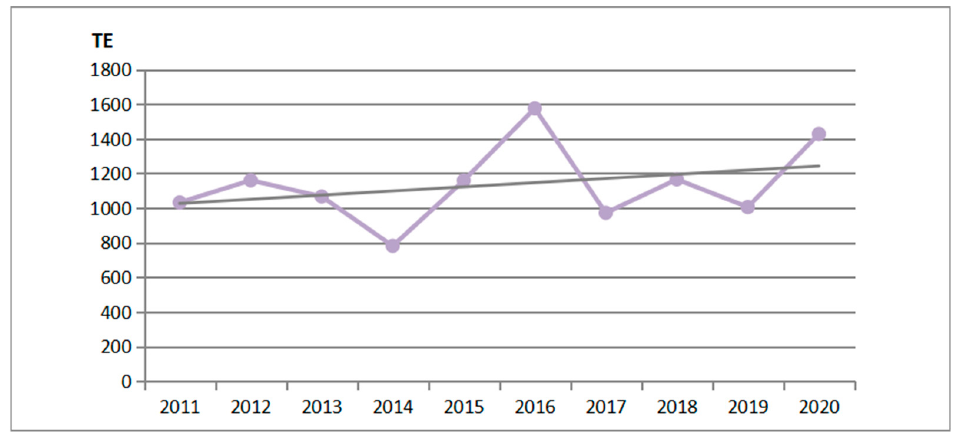
Figure 10. Thermal energy (TE, sum of daily average temperatures above 0 °C per year) change from 2011 to 2020.